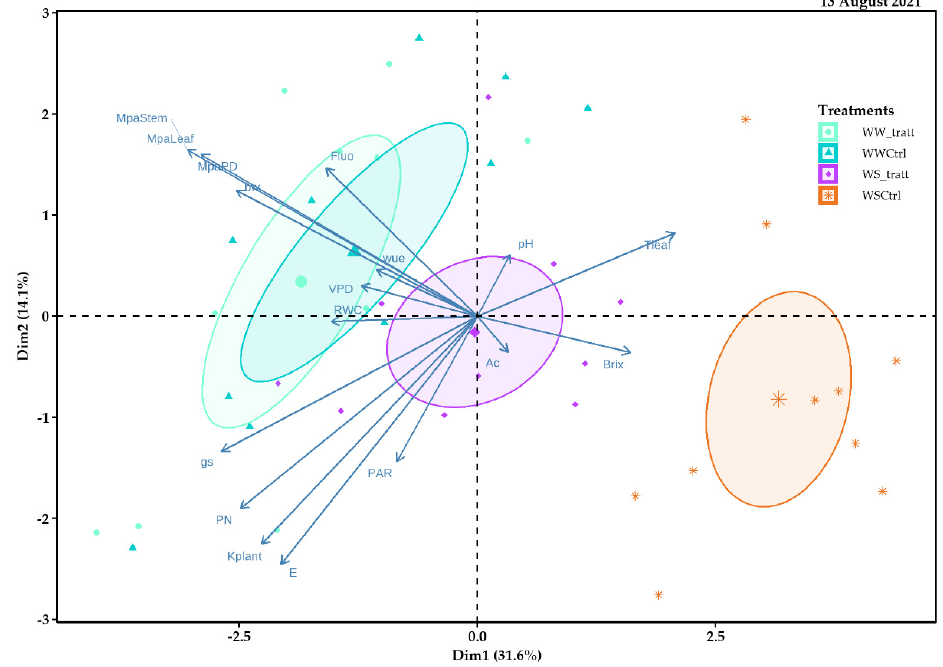
Figure 13. Relationship between principal component 1 (Dim1) and principal component 2 (Dim2) for response variables analyzed in field experiments with Pinot Noir cultivar subjected to different treatments (WWt, WWCtrl, WSt, and WSCtrl) during the 2021 season (13 August 2021).